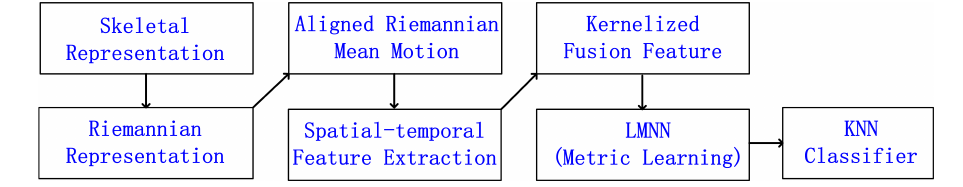
Figure 2. Overview of the proposed